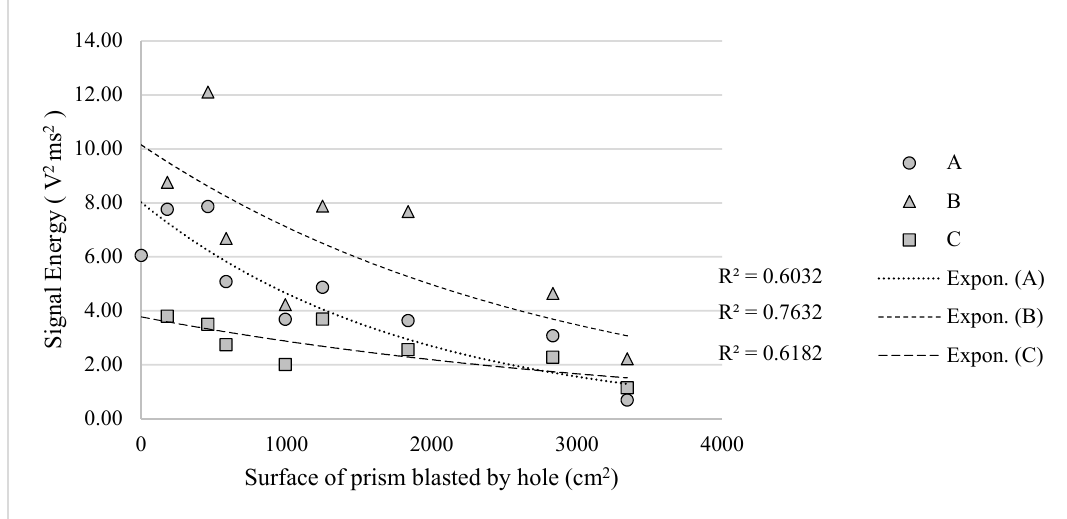
Figure 10. Considering the signal energy, by integrating the voltage values of the oscillation along the duration of the same oscillations, all three sensors showed the same shock behavior.